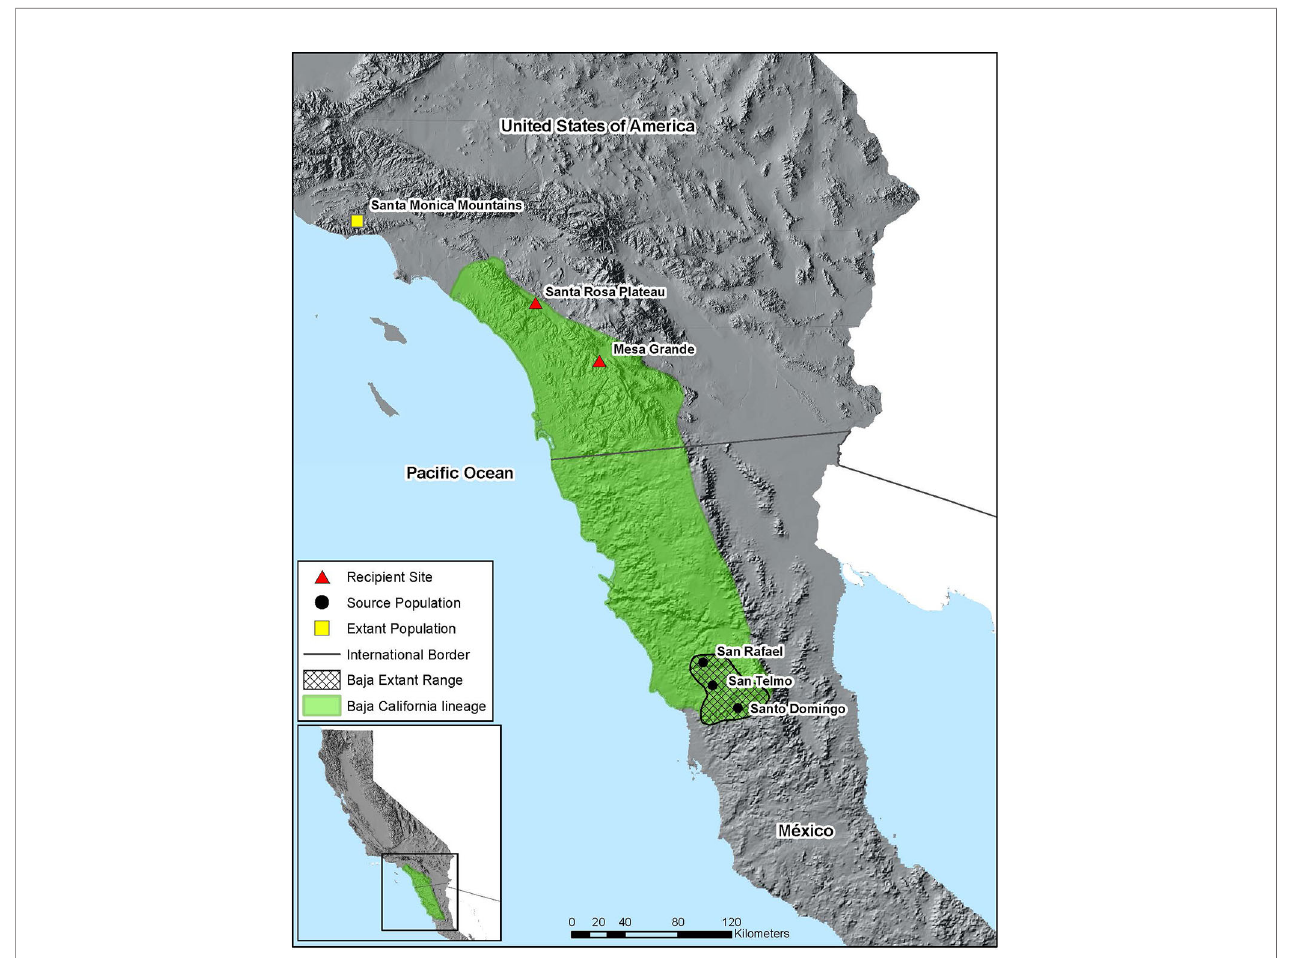
FIGURE 1 | Map of translocation project area. Green polygon shows the approximate distribution of the Baja California lineage of R. draytonii based on available genetic data and museum specimens (records not shown). Polygon with cross-hatching shows R. draytonii occupancy in Baja California, Me ́ xico. Triangles represent the two recipient sites in California and circles represent the source populations in the Sierra de San Pedro Martir mountains. The single yellow square represents the most southern R. draytonii population in California (in the Santa Monica Mountains), which is the northern limit of the 420 km range